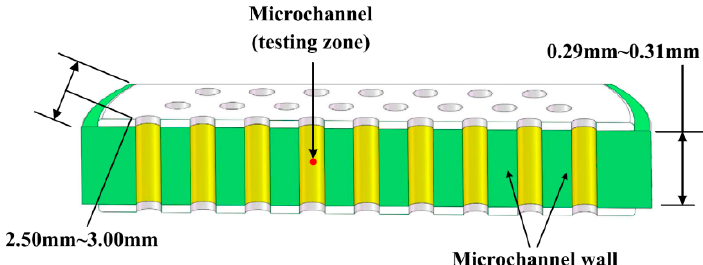
Figure 2. The sample sketch for properties characterized by atomic force microscope (AFM), Kelvin force microscopy (KFM) and X-ray photoelectron spectroscopy (XPS). AFM and KFM measurements were both in a low frequency vibration isolation device to reduce the external disturbance. XPS experimentation was carried out under ultra high vacuum ( ≤ 2 × 10 − 9 torr) with Al K α radiation ( h ν = 1486.6 eV), the detected binding energies were from 0 eV to 1350 eV. The temperatures of samples were all no more than 20 °C in these three tests.